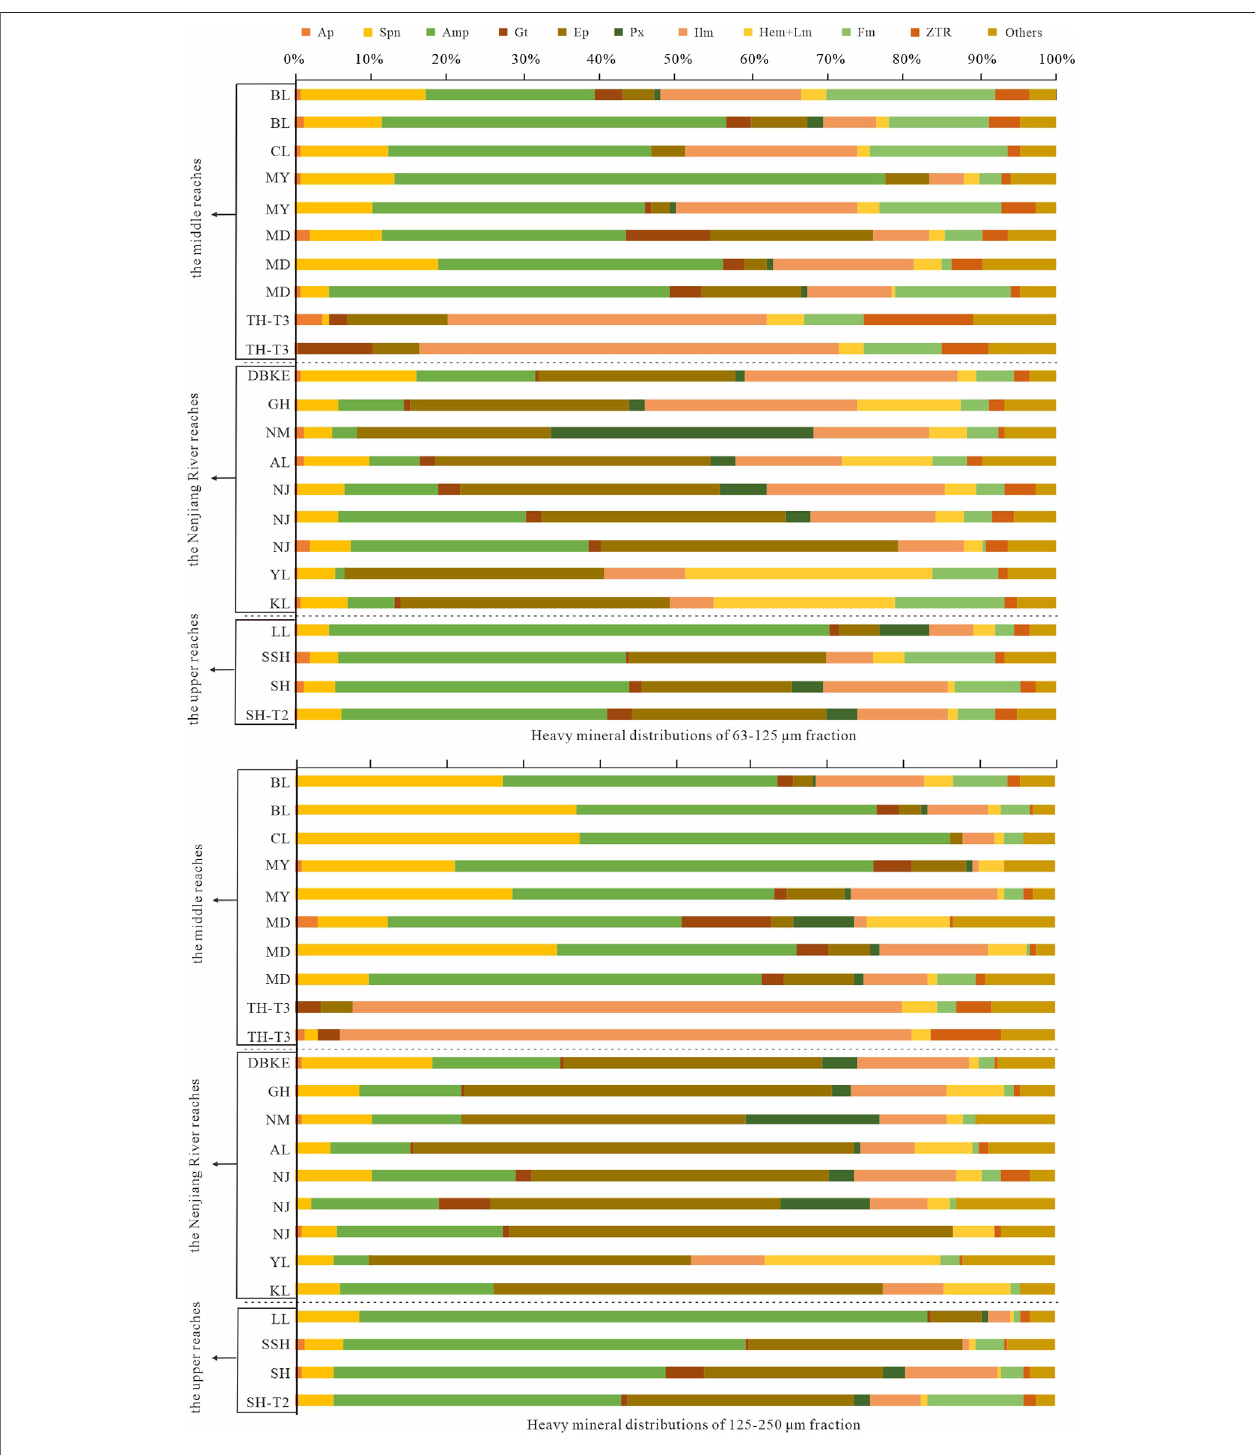
FIGURE 3 | Heavy mineral abundance of the Songhua River at 63 – 125 μ m and 125 – 250 μ m fraction, expressed as relative weight percentage (wt%). Systematic mineral abbreviation list: Ap = apatite, Spn = sphene, Amp = amphibole, Gt = garnet, Ep = epidote, Px = pyroxene, Ilm = ilmenite, Hem = hematite, Lm = limonite, Fm = ferromagnetic minerals, ZTR = zircon + tourmaline + rutile. (For interpretation of the references to colour in this fi gure legend, the reader is referred to the web version of this article.)